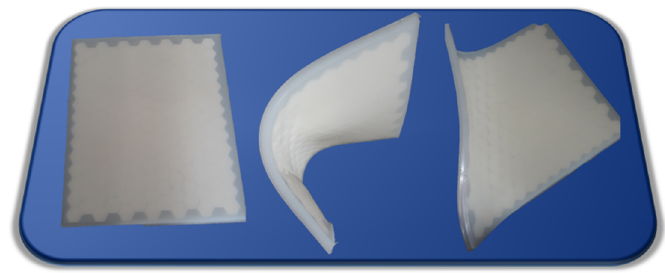
Figure 1. Hybrid silicone-ceramic composite—general view.